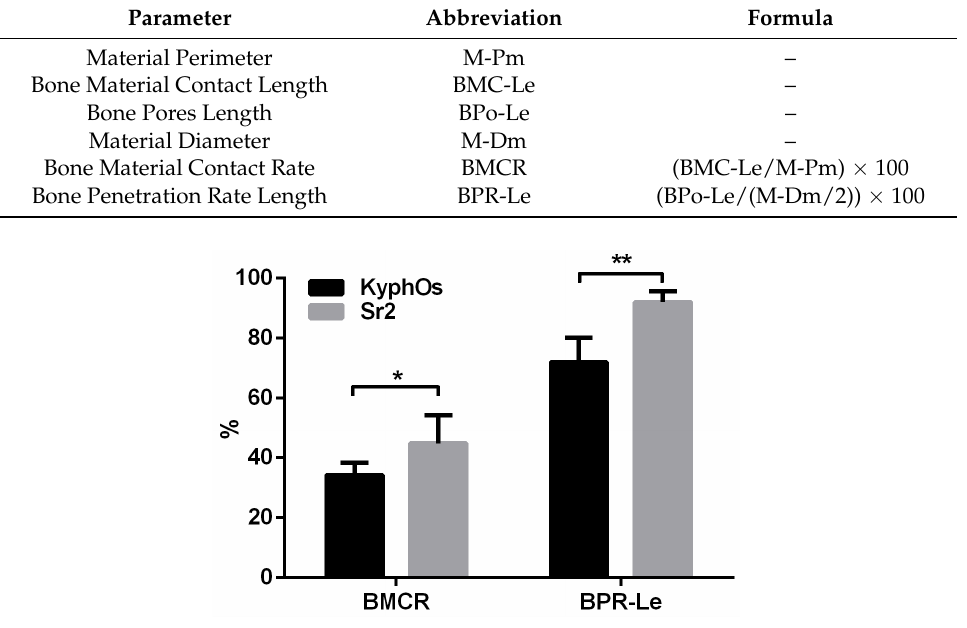
Figure 10. Histomorphometric data. The indicators BMCR and BPR-Le are explained in Table 4. * p < 0.5; ** p < 0.1. Table 4. Parameters observed and evaluated in histomorphometric analysis.